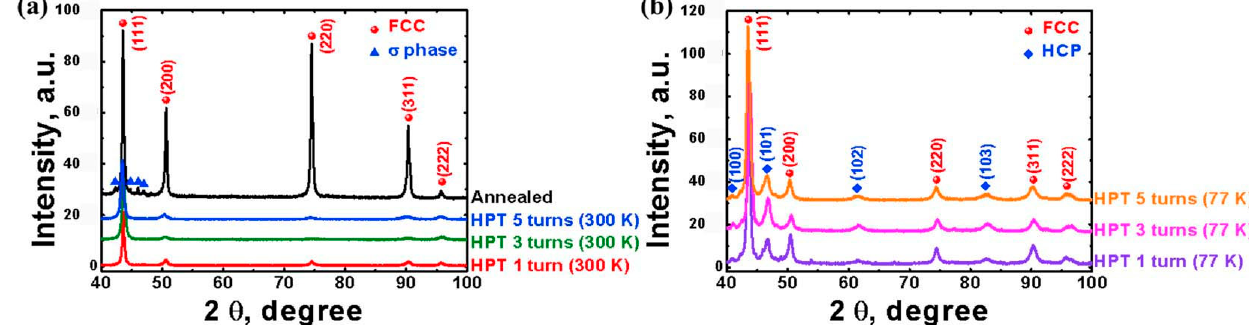
Figure 5. XRD patterns of the Co 20 Cr 26 Fe 20 Mn 20 Ni 14 alloy in the annealed state and after HPT by 1, 3, and 5 anvil turns were conducted ( a ) at 300 K and ( b ) at 77 K. The peak intensity is shown in arbi- trary units. Reprinted with permission from Ref. [25]. Copyright 2017 Springer.